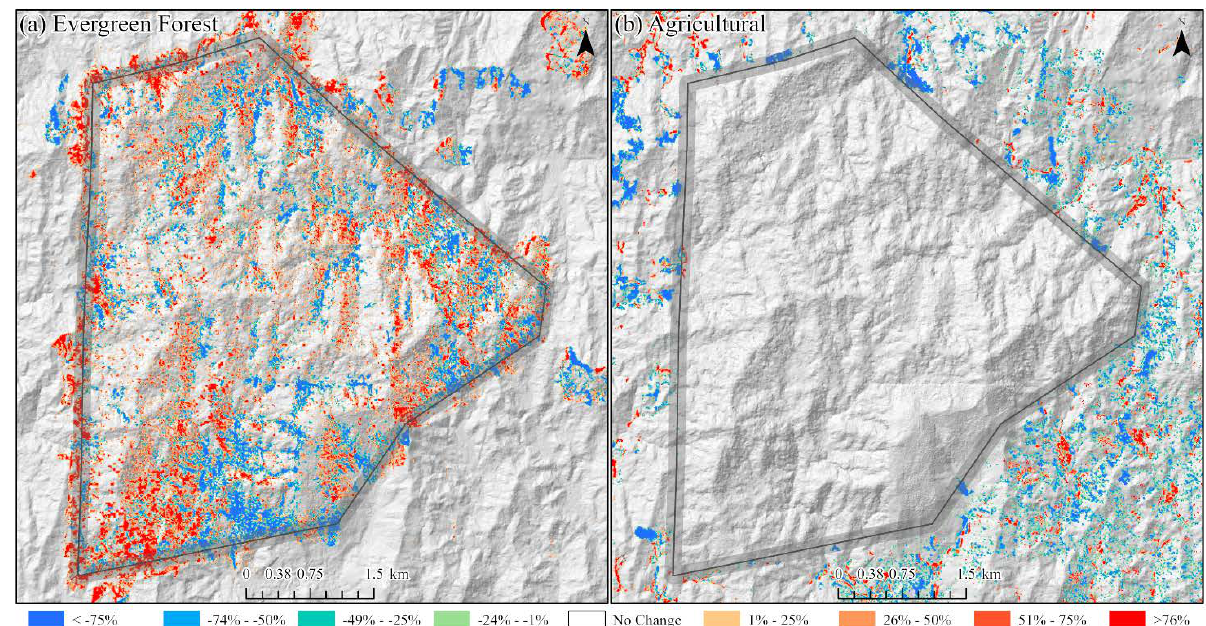
Figure 19. Percent change of ( a ) Evergreen Forest and ( b ) Agriculture—including Row Crops and Fallow—over the BNR overlain over a DEM, showing areas of increased (red) and decreased (blue) extents based on a 10 m × 10 m grid cell. The BNR boundary is shown via the black line and the ZOP and 100 m region within the BNR used for change analysis is displayed through the gray polygon.